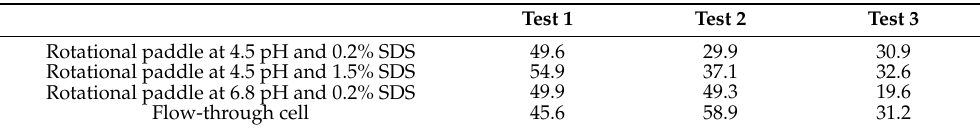
Figure 5. Mean dissolution results obtained with the rotational paddle dissolution equipment at 6.8 pH and 0.2% w / v SDS.